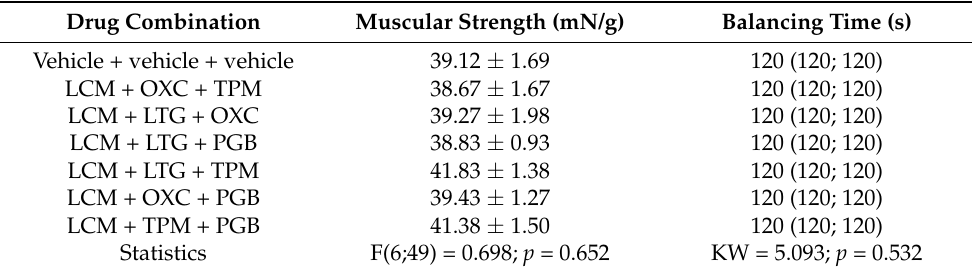
Table 3. Potential acute adverse effects in mice subjected to the grip-strength and rotarod tests. Drug Combination Muscular Strength (mN/g) Balancing Time (s) Vehicle + vehicle +